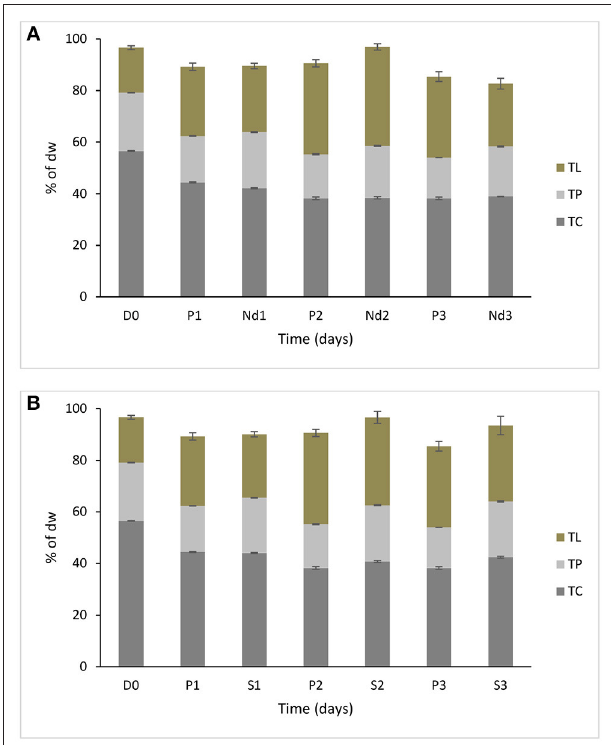
FIGURE 1 | Biochemical composition of S. dimorphus over time (three days) (A) under nutrient deprivation stress and (B) 5% salt stress. Nutrient deprivation stress (Nd1, Nd2, and Nd3) was created by using tap water. Prolonged growth in original wastewater (P1, P2, and P3) algae were kept in municipal wastewater where previously have been grown for 6 days. Treatments of 5% salt stress were represented in S1, S2, and S3. D0 was grown for six days in municipal wastewater before treatment and it represents the start of the experiment. Total lipid (TL), total protein (TP) and total carbohydrate (TC) concentrations are reported as % of biomass dry weight. Bars represent the mean ± SE of five replicates for TL and three replicates for TP and TC.